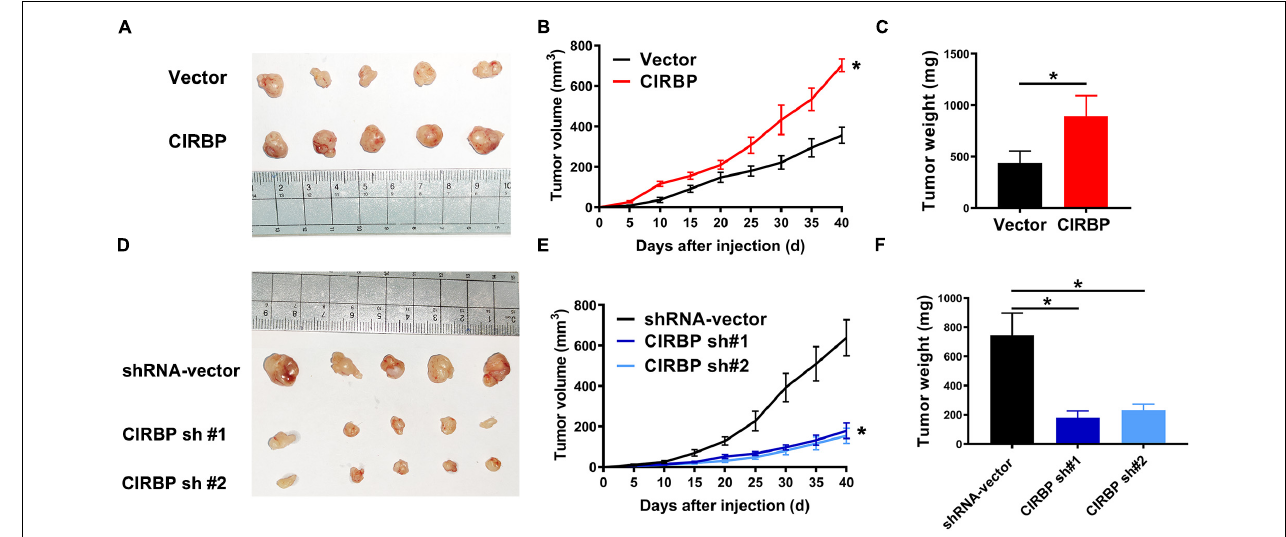
FIGURE 4 | The lower levels of CIRBP expression in pancreatic cancer cells correlate with slower tumor growth in vivo . (A,D) Tumors from CIRBP overexpression (A) or knockdown (D) PANC-1 cells and their controls ( n = 5/groups). (B,E) Tumor growth curves. The sizes of tumors were measured every 5 days after tumor cell inoculation. * P < 0.05, repeated measures analyses of variance with Bonferroni correction. (C,F) Tumor weight of each group was measured at the end of the experiments. Data are presented as means ± SD. * P < 0.05, unpaired student’s t